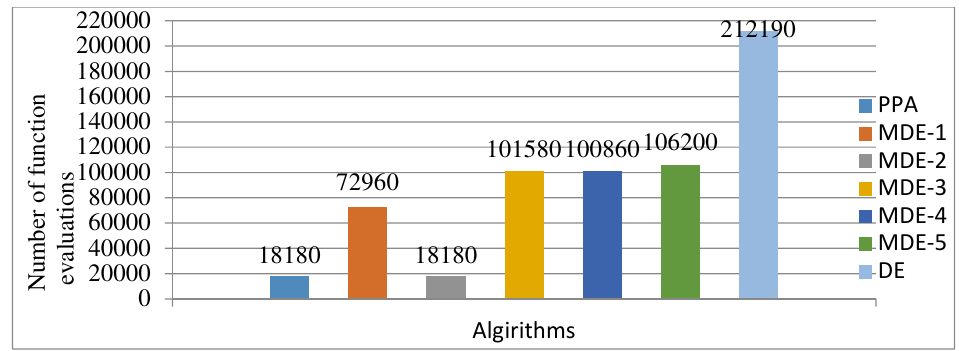
FIG.9: NUMBER OF TOTAL FUNCTION EVALUATIONS TAKEN BY PPA, DE AND ITS VARIANTS IN SOLVING THE 6-BUS PROBLEM OF